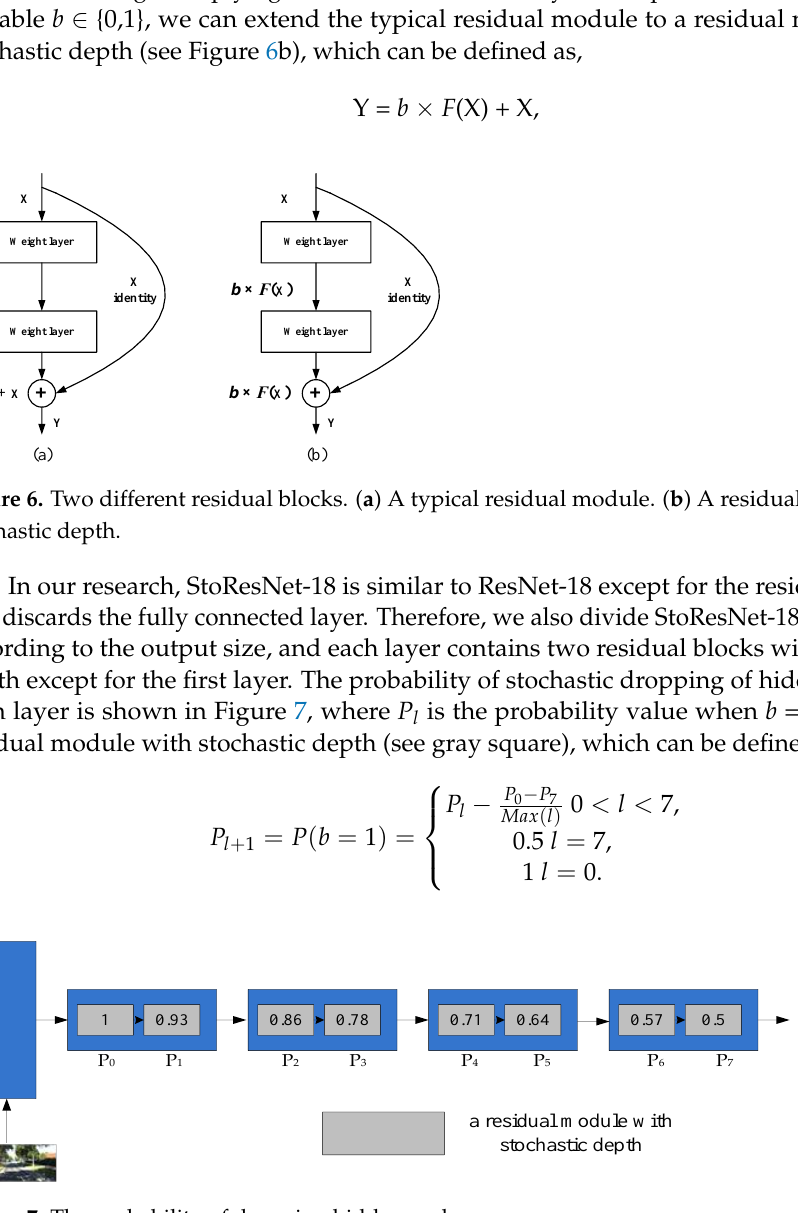
Figure 7. The probability of dropping hidden nodes.